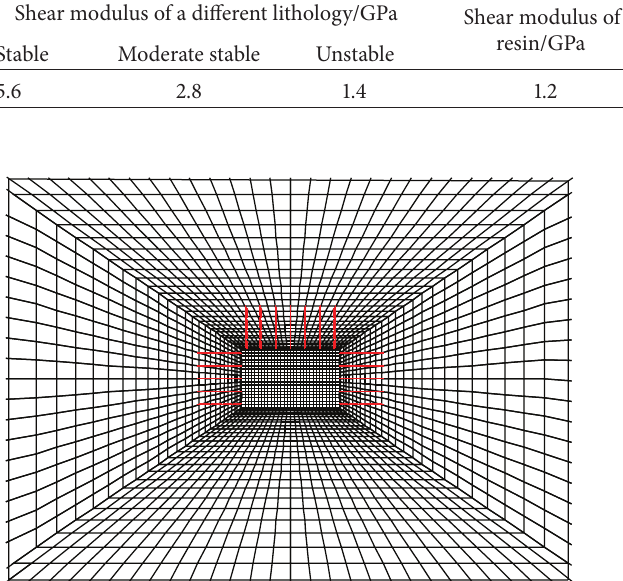
Figure 1: Schematic illustration of three-dimensional model. those generated by blasting, seismic loading, and periodic weighting during mining.